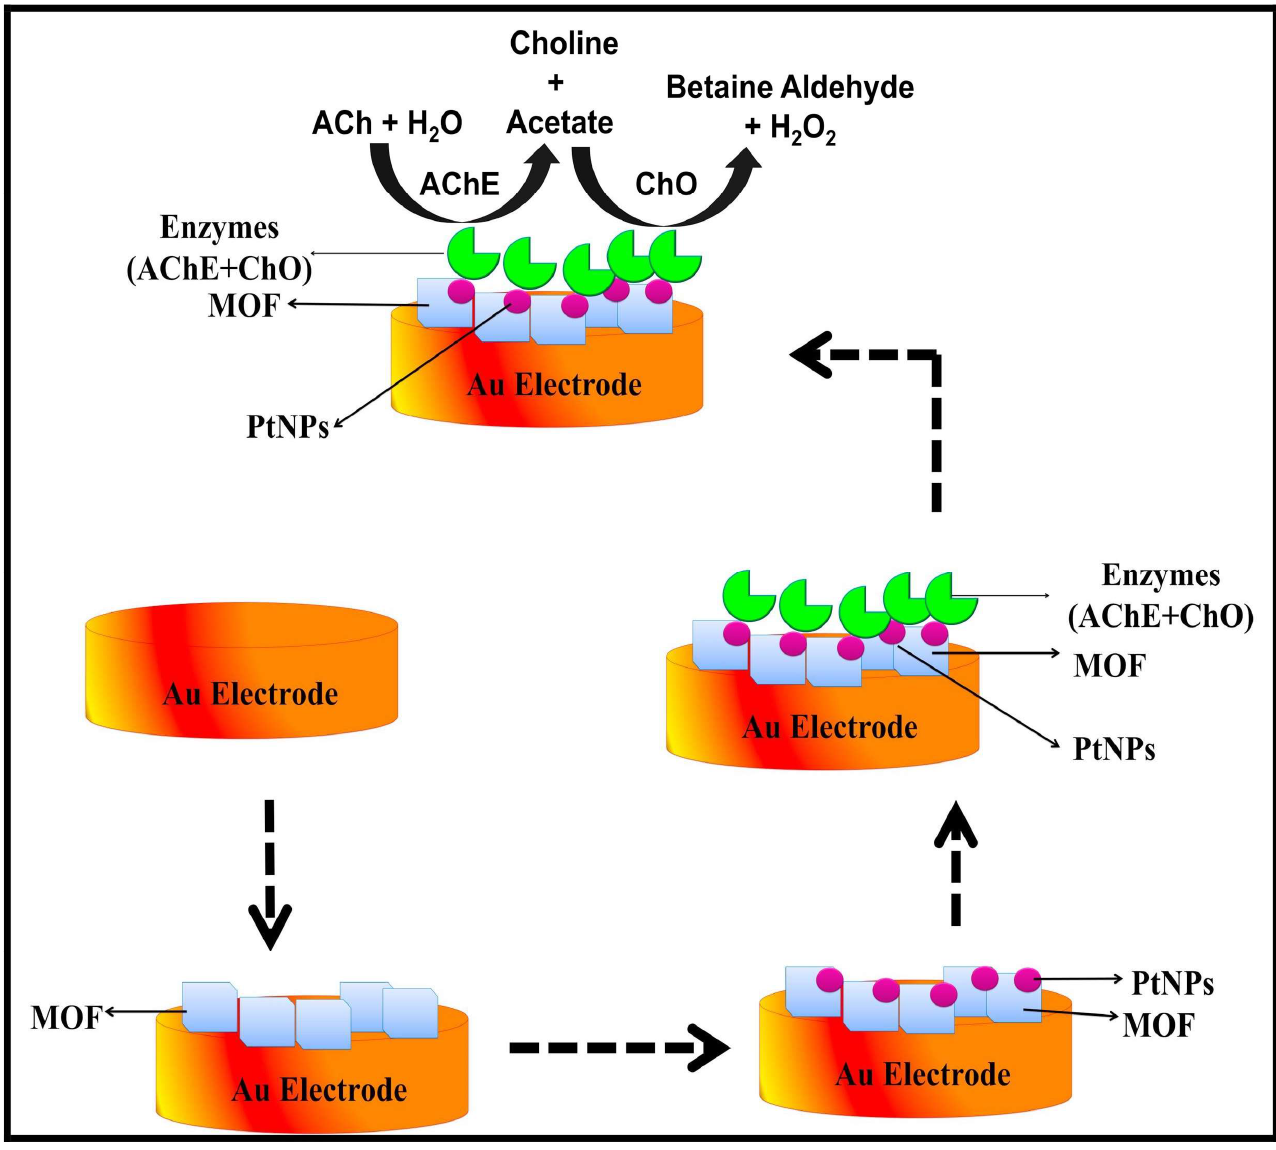
Figure 6. Schematic illustration of the AChE-ChO/PtNPs/MOF nano-composite onto the Au elec- trode and subsequent recognition of Ach (Reprinted with permission from Ref. [54]. Copyright 2019, Elsevier).